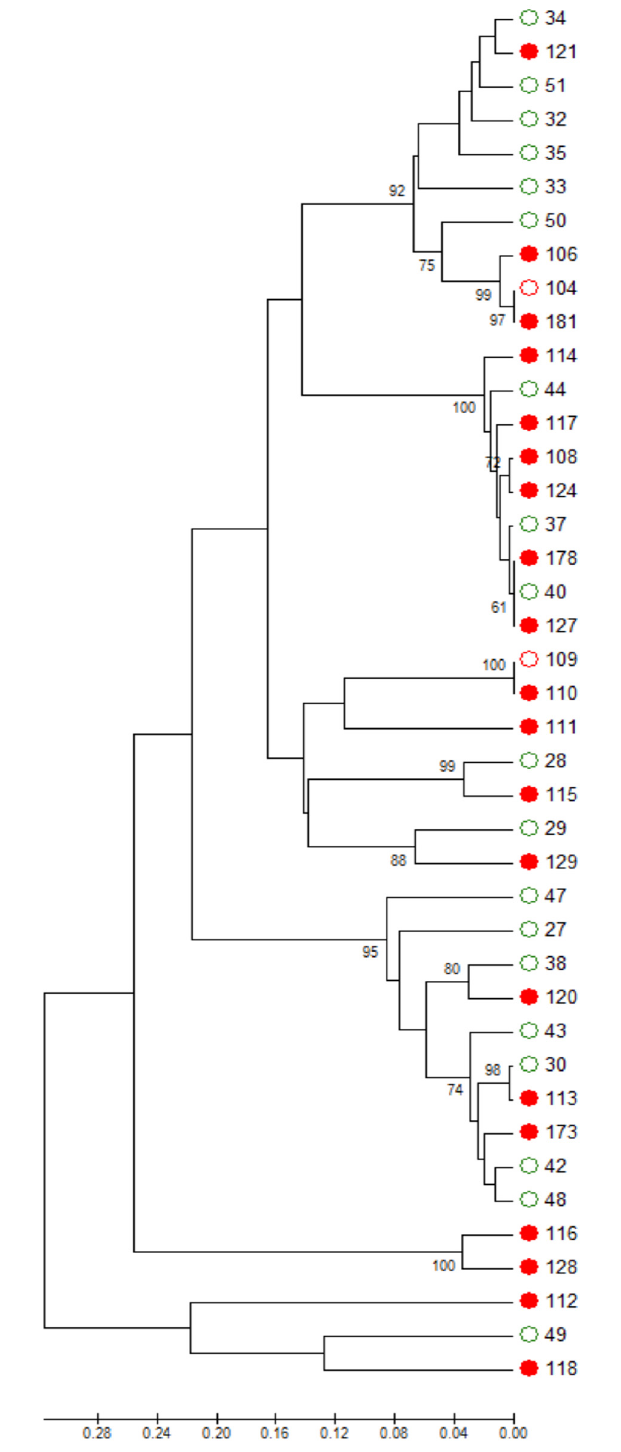
Fig 1. Neighbor-joining tree of invasive and colonizing Candida isolates. Red dots = invasive Candida isolates; green circles = colonizing Candida isolates from patients without candidemia; red circles = oral colonizing isolates from patients with candidemia. The percentage of replicate trees in which the associated taxa clustered together in the bootstrap test (1000 replicates) are shown next to the branches. The tree is drawn to scale, with branch lengths in the same units as those of the evolutionary distances used to infer the phylogenetic tree. The evolutionary distances are in the units of the number of amino acid differences per site.